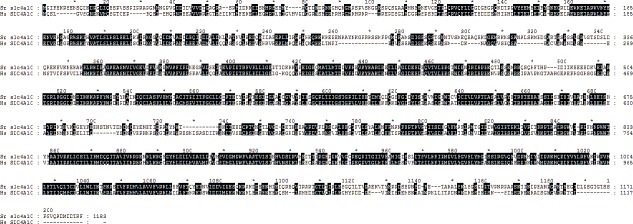
Sequence alignment of the human NBCn2 (Slc4a10) and the sea urchin SpSlc4a10.Alignment of deduced amino acid sequences demonstrates 44% identity between the human Slc4a10 and the sea urchin SpSlc4a10.